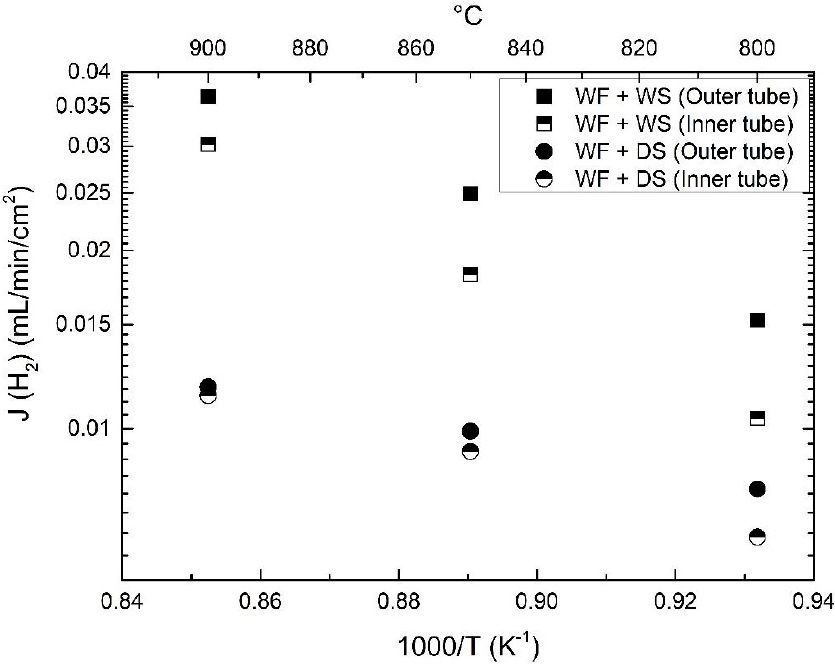
Figure 8. Comparison of sweep side effect on apparent hydrogen flux as a function of temperature. The feed is wet 48.75% H 2 with a constant flow of 50 mL/min, and the sweep Ar flow is 100 mL/min.